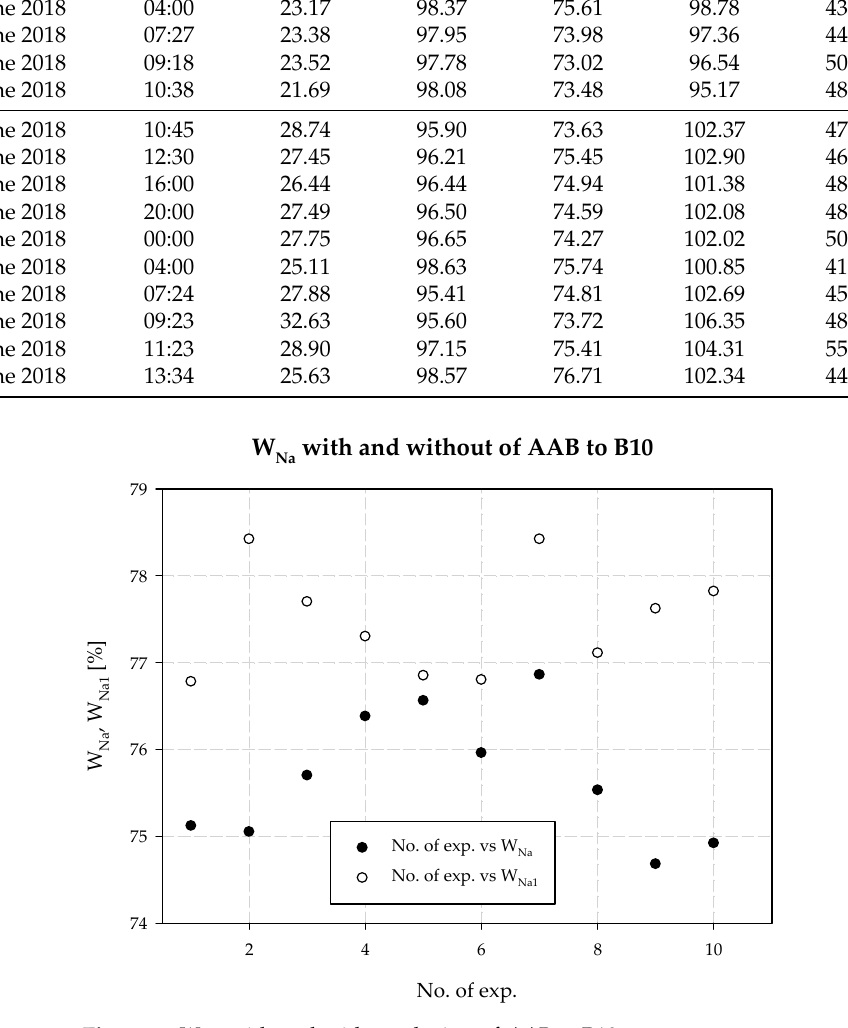
Figure 6. W Na with and without dosing of AAB to B10.